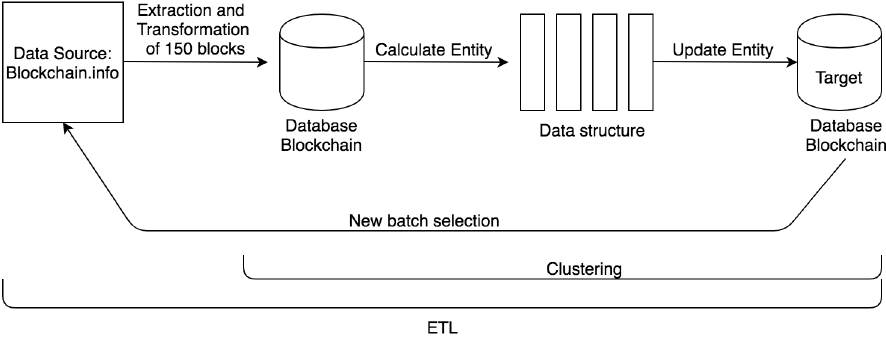
Figure 1. ETL workflow representation for blockchain data